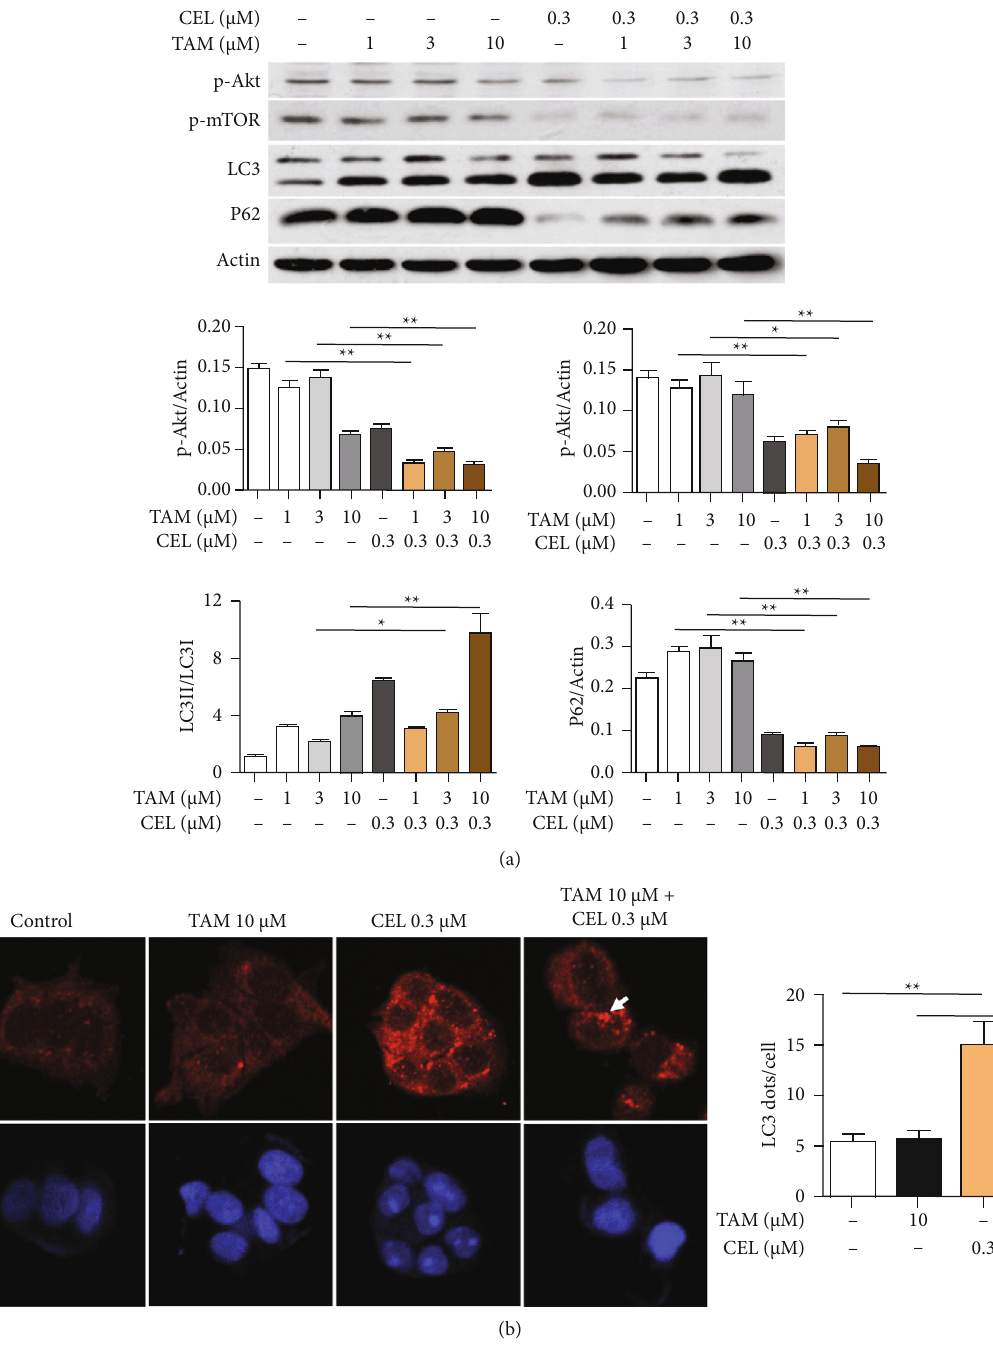
Figure 5: Combination of celastrol and TAM triggers autophagy in MCF-7 cells. (a) Protein levels of LC3, P62, p-Akt, and p-mTOR were detected by western blot after treatment with celastrol (0.3 μ M), TAM (1, 3, and 10 μ M), or the combination for 24 hours in MCF-7 cells. The protein expression of LC3II increased signi fi cantly, the ratio of LC3II/U increased ( P < 0 : 05 ), and the protein level of P62, an autophagy substrate marker, was also signi fi cantly reduced in the combination group. In addition, the protein expression of p-Akt and p-mTOR was repressed in the combination group. (b) MCF-7 cells were treated with celastrol (0.3 μ M), tamoxifen (10 μ M) alone, or the combination for 6h. Cells were fi xed and double-labelled with an anti-LC3 antibody (red), and nuclei were stained with DAPI (blue). An increase in red punctate aggregation in the cytoplasm indicated the activation of autophagy in the celastrol group and combination group. The white arrow points to an